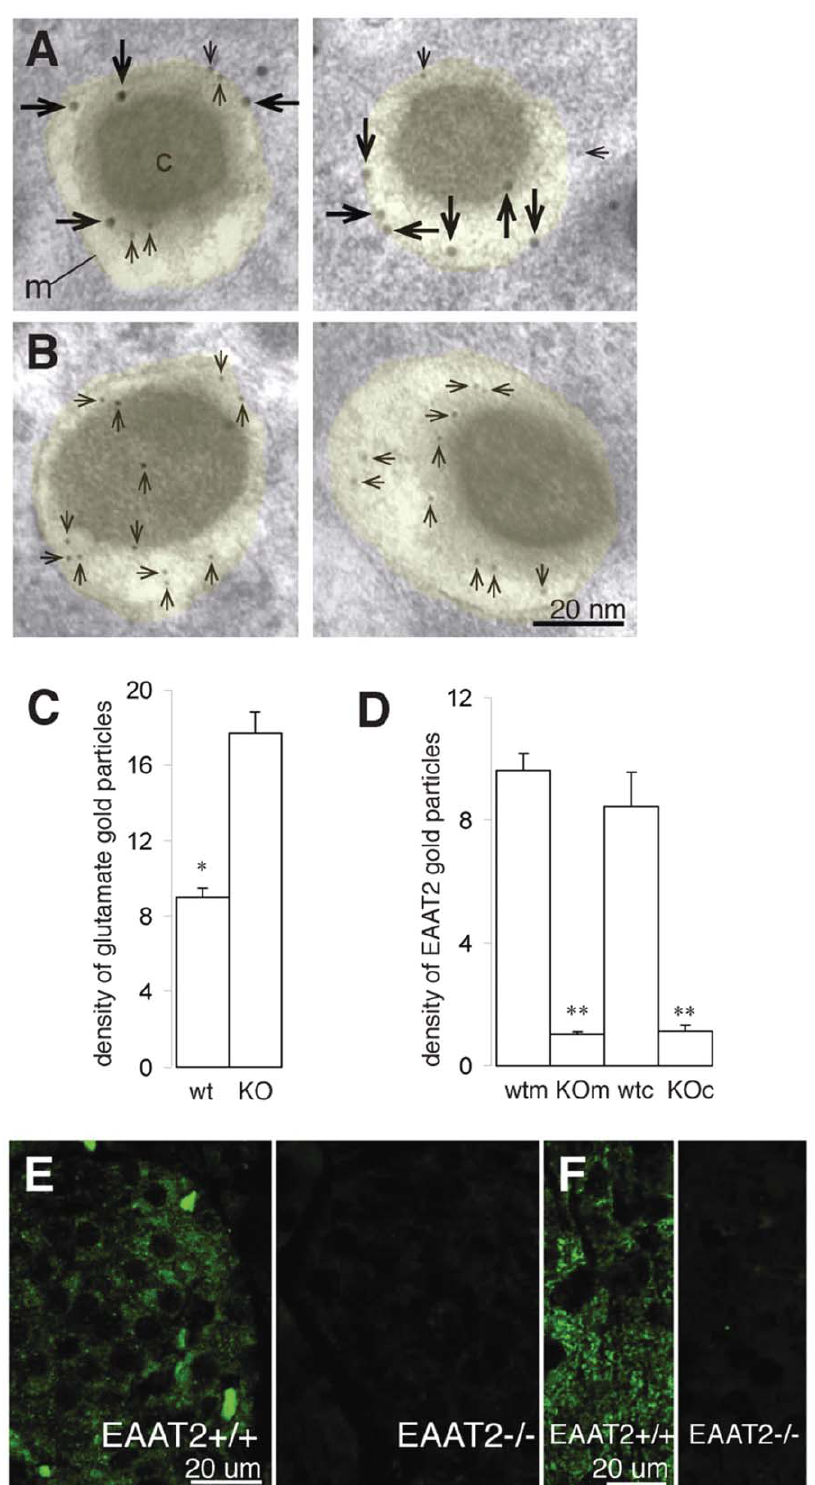
Figure 4. Lack of EAAT2 and increased concentration of glutamate in secretory granules in EAAT2 KO mice. (A–B) Immunogold electron micrographs showing EAAT2 (large gold particles, long arrows) and glutamate (small gold particles, short arrows) in b -cell secretory granules (transparent yellow) in wt (A) and KO (B) islets (two examples of secretory granules shown for each phenotype). m, granule membrane. c, granule core. (C–D) Quantitative representation of the glutamate (C) and EAAT2 (D) gold particle densities in b -cell secretory granules in wild type (wt) and knock out (KO) mice. The values are mean numbers of gold particles/ m m 2 6 SEM in 4 KO and 4 wt animals (background subtracted, see Methods). 119 secretory granules in wt mice and 179 secretory granules in KO mice were included in the quantifications. *, the value in KO secretory granules is significantly higher than the value in wt secretory granules (p , 0.01, Mann-Whitney-U test, two tails) and **, the values in the limiting membrane (m)